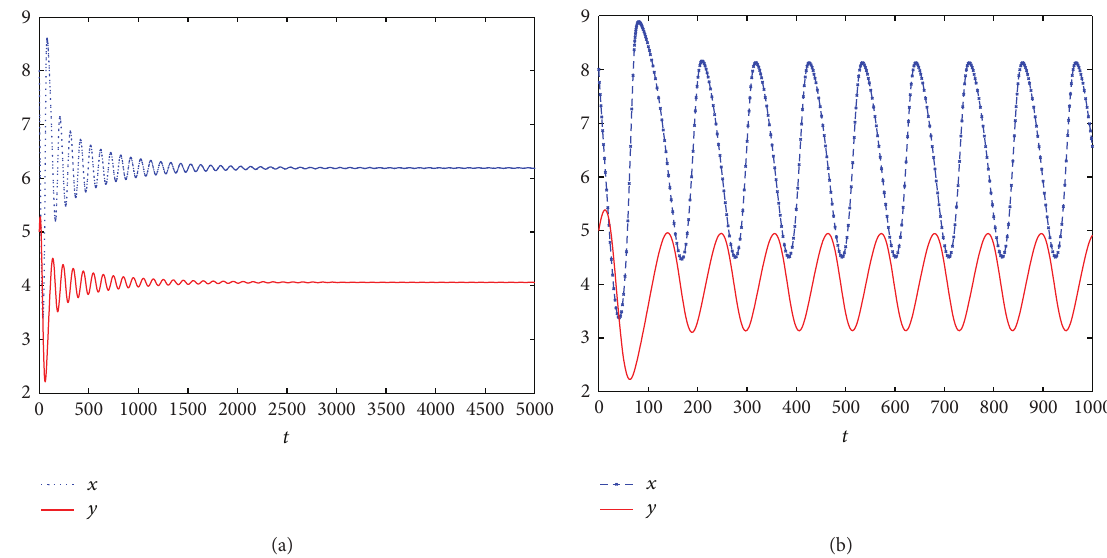
Figure 2: The infected steady state 𝐸 ∗ of system (1) is asymptotically stable when 𝜃 = 4 (a), and unstable when 𝜃 = 5 (b). The rest parameter values are 𝑟 = 0.1 , 𝐾 = 10 , 𝛽 = 0.2 , 𝑎 = 0.13 , and 𝜀 = 0.3 , and the initial values are 𝑥 0 = 8 and 𝑦 0 = 5